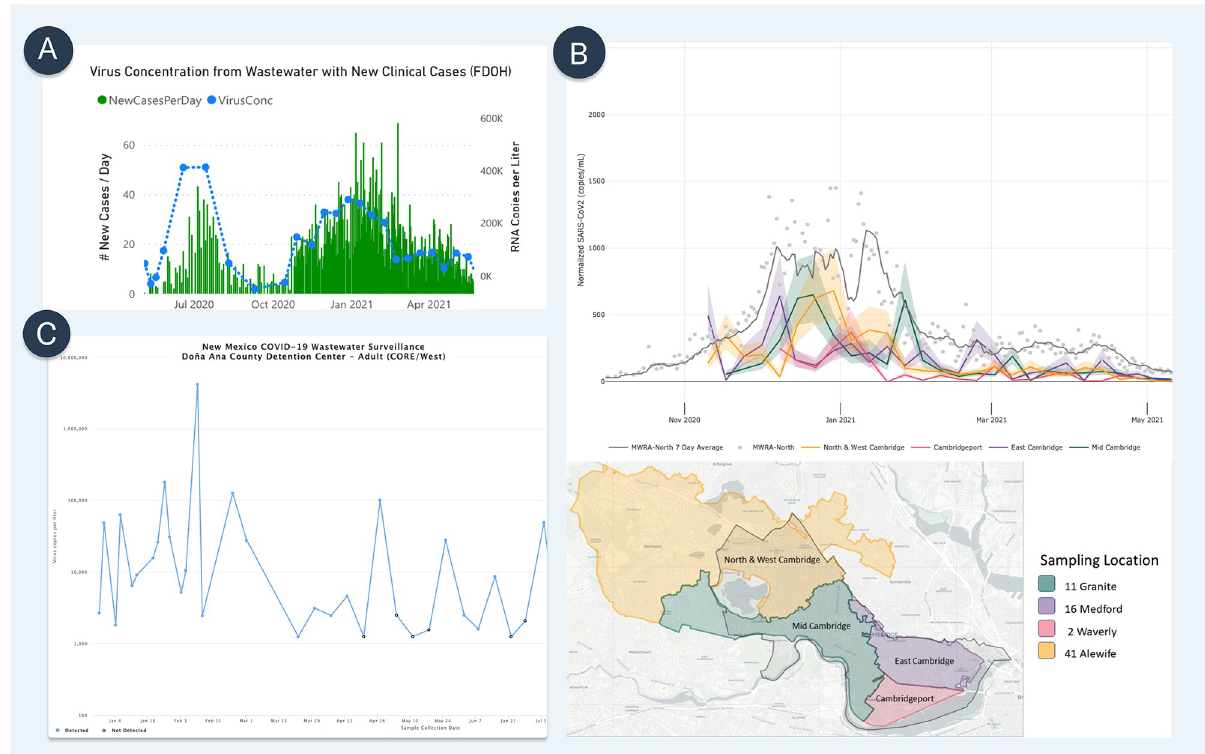
Fig 2. Examples of wastewater surveillance data visualization. (A) Wastewater treatment plant level: Wastewater Surveillance dashboard by the Loxahatchee River District, FL. Wastewater viral concentrations (blue dots) are compared against clinical case data (green bar). Screenshot taken by the authors on June 12, 2021, from https://loxahatcheeriver.org/wastewater-surveillance/. (B) Neighborhood level: Weekly Municipal Wastewater Sampling Data by Cambridge COVID-19 Data Center, Cambridge, MA. Samples are collected from four manholes within the City of Cambridge, which together cover the whole city. Wastewater viral concentrations at the four upstream catchments (orange, red, purple. green) are compared against each other and against a downstream catchment (gray) that covers Greater Boston. Screenshot taken by the authors on May 5, 2021, from https://cityofcambridge. shinyapps.io/COVID19/?tab=wastewater. (C) Building level: New Mexico Wastewater Surveillance System Data Dashboard, New Mexico Environment Department, NM. The line graphs represent the amount of the virus measured in wastewater samples collected at the correctional facility through time (blue). The current level of concern (bottom left) is based on the most recent sample while the current trend (bottom right) is based on the three most recently collected samples at each facility. Increasing and decreasing trends are flagged when there is an order of magnitude (or 10-fold) change in measurements. Screenshot taken by the authors on July 27, 2021